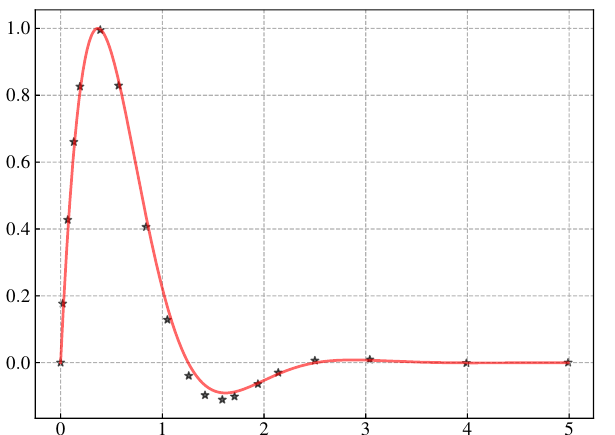
Figure 4. Template signal. Red line is the template function and the black star is the defined CPG